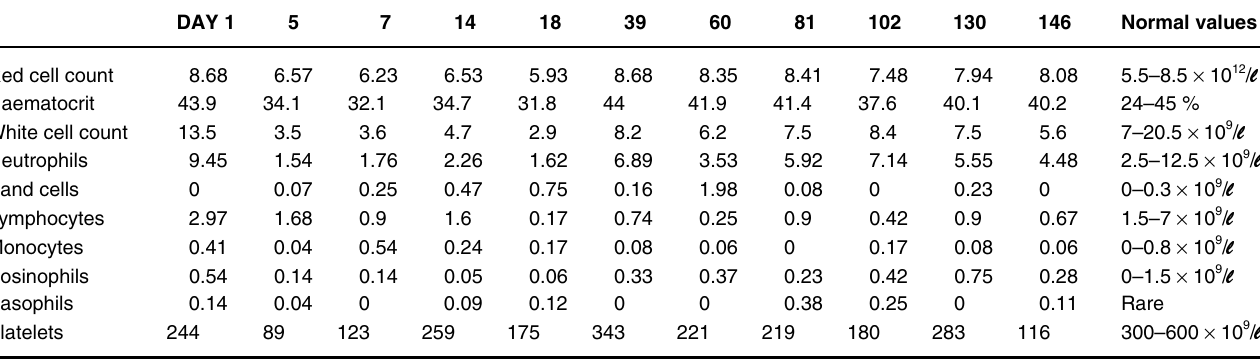
Table 1: Haematological data.